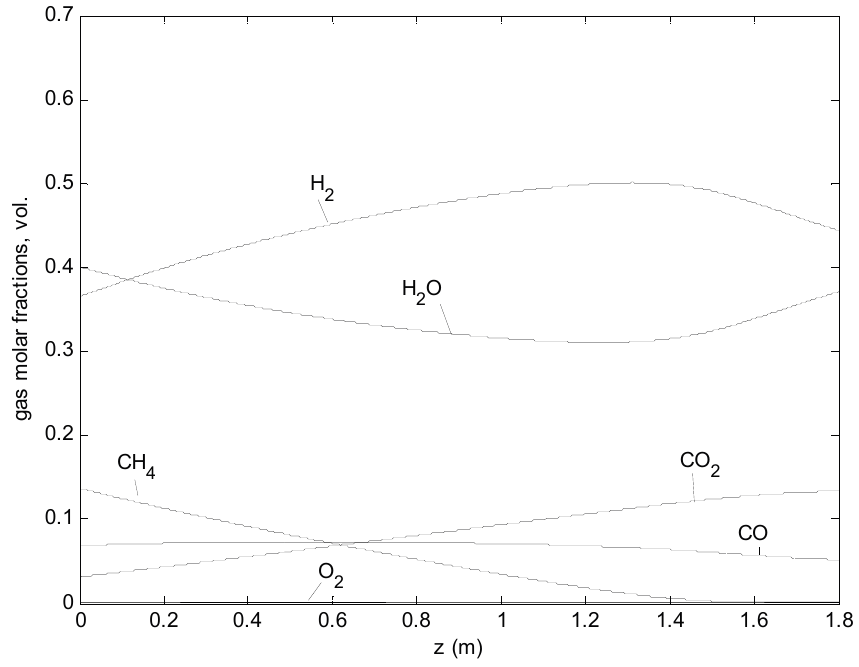
Figure 5. Axial mole fraction profiles at the permeate side of the ATR-MR (reference